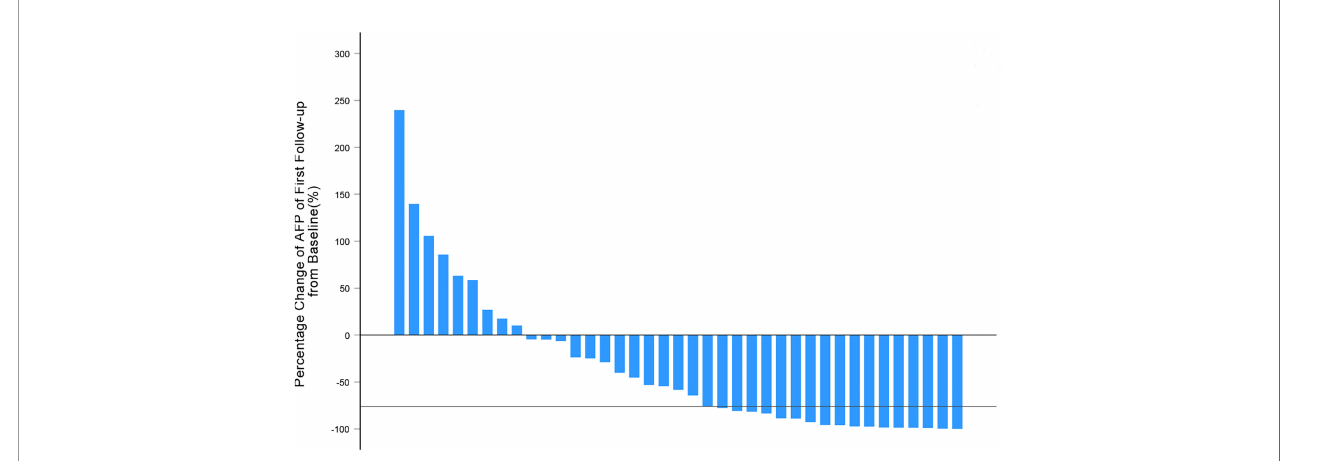
-RECIST criteria might be a promising tool for identifying tumor response of conversion-radiotherapy for uHCC before hepatectomy.